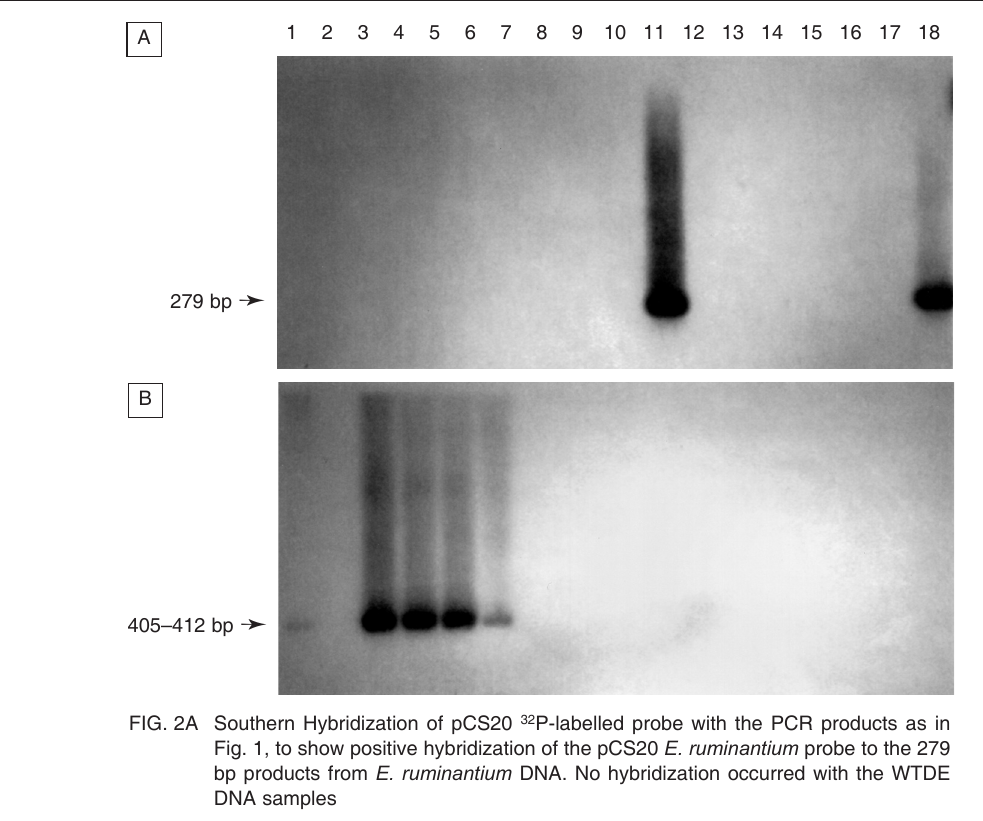
FIG. 2A Southern Hybridization of pCS20 32 P-labelled probe with the PCR products as in Fig. 1, to show positive hybridization of the pCS20 E. ruminantium probe to the 279 bp products from E. ruminantium DNA. No hybridization occurred with the WTDE DNA samples FIG. 2B Southern Hybridization of 405–412 bp WTDE PCR product 32 P-labelled as probe with the PCR products as in Fig. 1 and show positive hybridization of the probe to the WTDE DNA samples but not to the samples from E. ruminantium